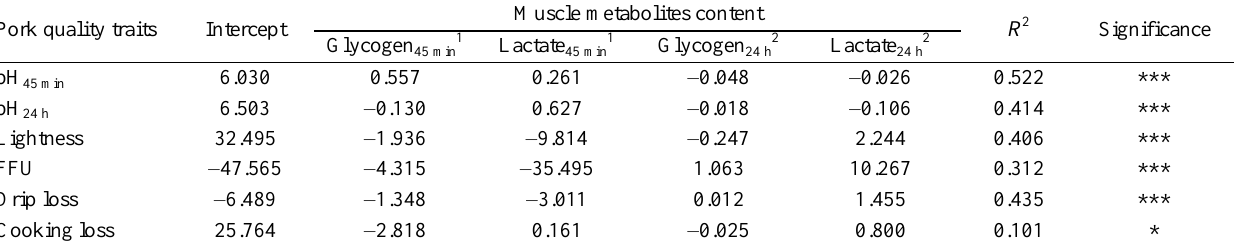
Table 4. Multiple regression models for certain pork quality traits using muscle glycogen and lactate contents measured at 45 min and 24 h